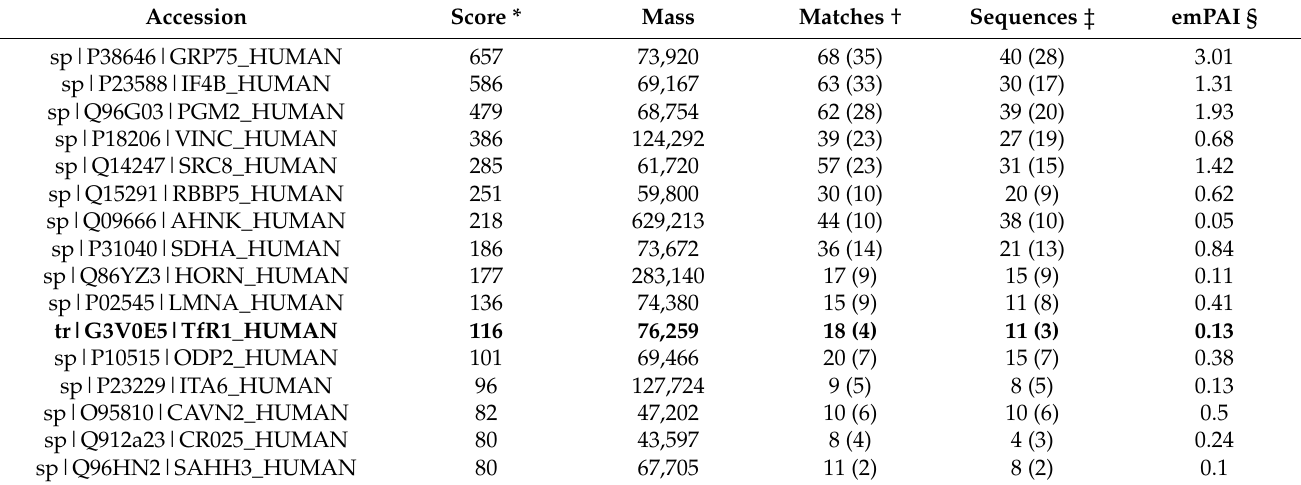
Table 2. Mass spectrometry analysis of proteins (scores > 80) interacting with 12b